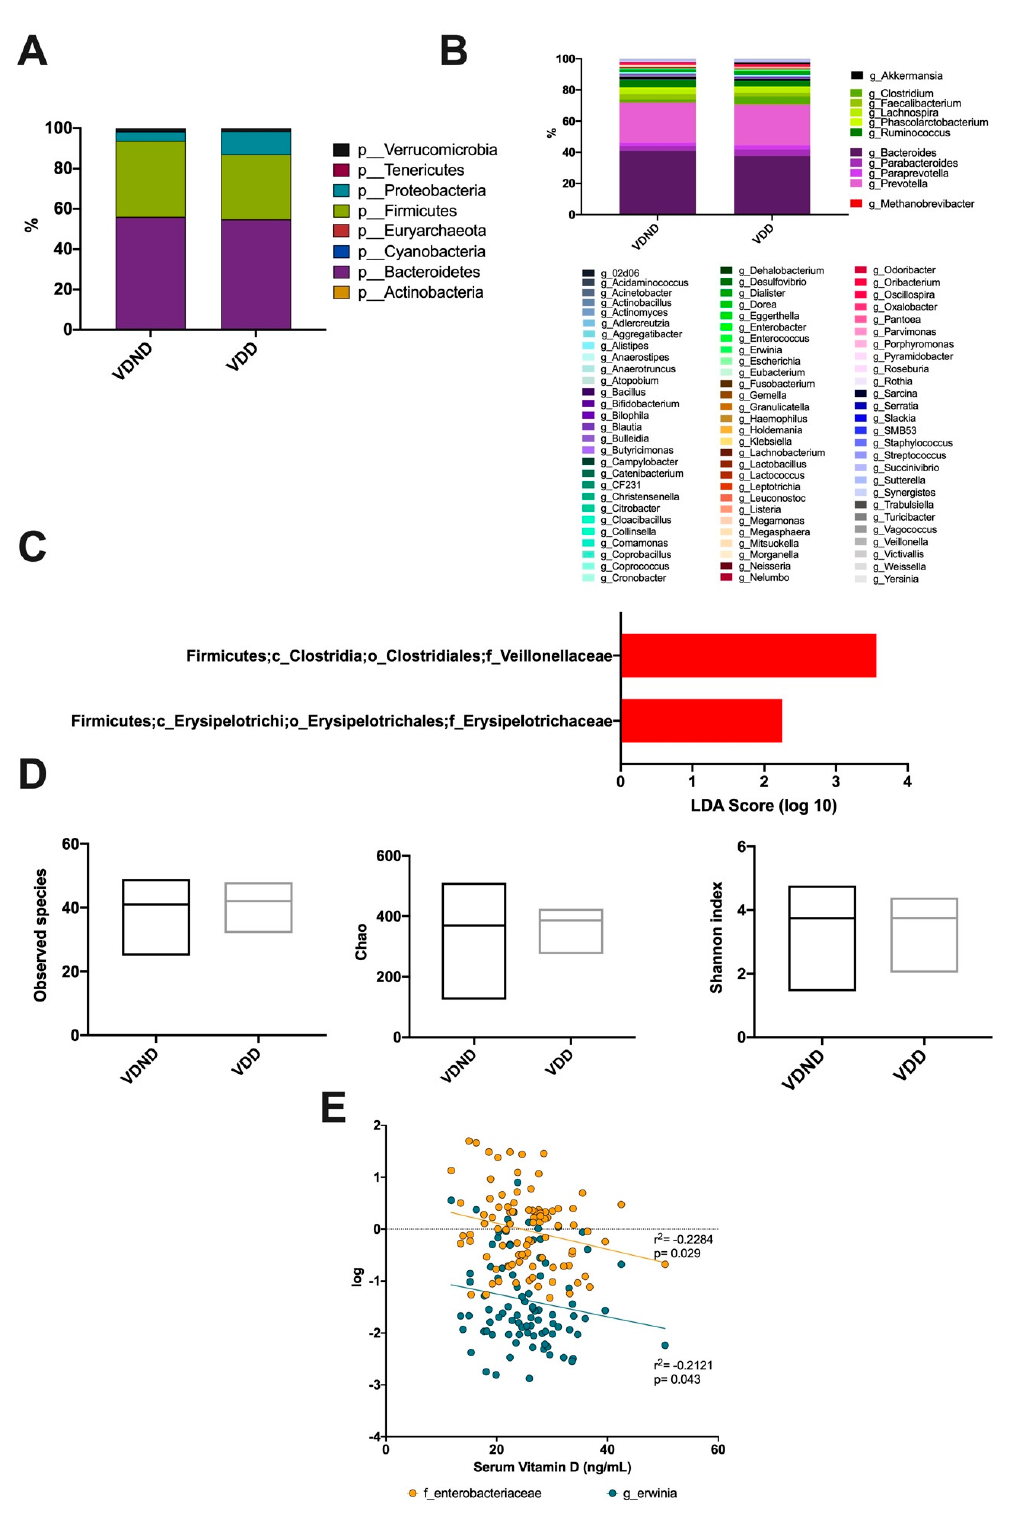
Figure 6. Association between vitamin D deficiency and bacterial community composition. ( A ) A total of seven phyla dominated the microbiota composition in postmenopausal no vitamin D-deficient women (VND) and postmenopausal vitamin D-deficient women (VDD); the predominant phyla were Bacteroidetes , colored purple, followed by Firmicutes , colored green. ( B ) At the genus level, the most abundant taxa were Akkermansia , Clostridium , Faecalibacterium , Lachnospira , Phascolarctobacterium , Ruminococcus , Bacteroides , Parabacteroides , Paraprevotella , Prevotella , and Methanobrevibacter . ( C ) Bacterial taxa differentially represented between groups identified by linear discriminant analysis (LDA) effect size. Only taxa with an alpha value of 0.05 and with an LDA score of at least 2 are